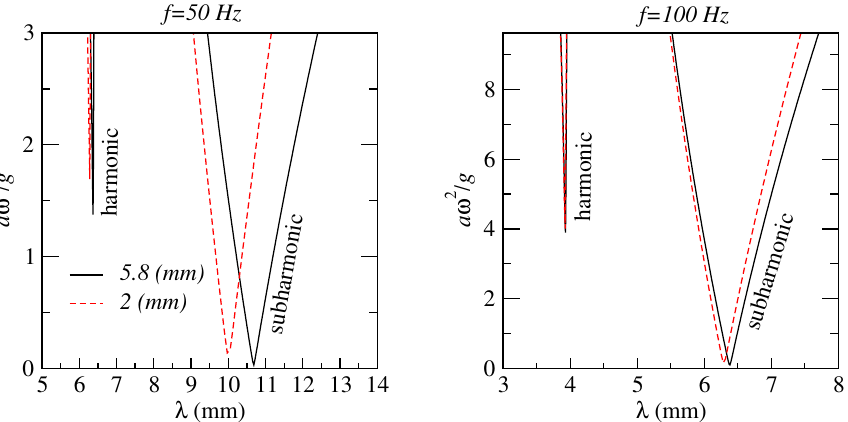
Figure 22. Stability diagram for h = 5.6mm and h = 2mm deep liquid metal layers showing two subharmonic Faraday tongues. The oscillation frequency of Faraday waves is half of the vertical vibration frequency f = 50Hz ( left ) and 100Hz ( right